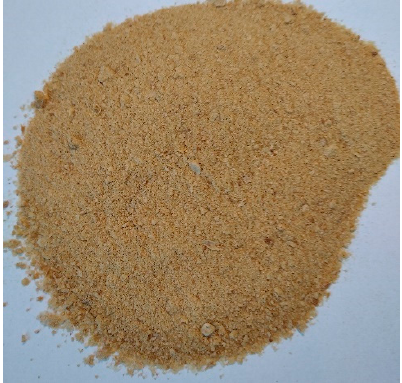
Figure 2. The dried powder of Y. lipolytica .